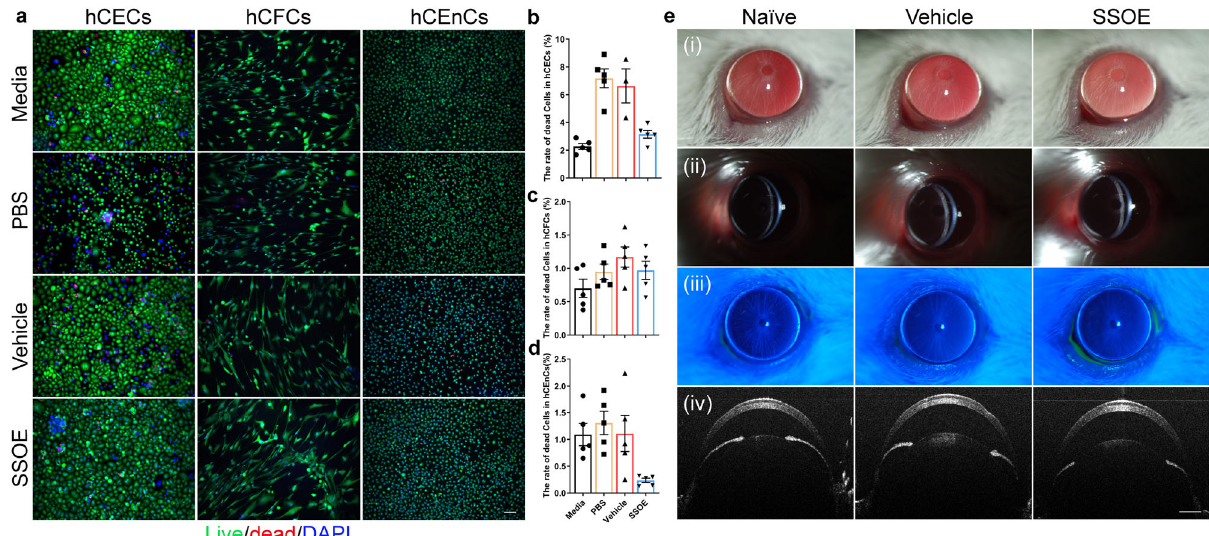
Fig.2|SafetyandbiocompatibilityofophthalmicSSOE.a Representativeimages of live/dead assay of human corneal epithelial cells (hCECs), human corneal fi bro- blastcells(hCFCs),andhumancornealendothelialcells(hCEnCs)after1hexposure toculturemedia,PBS,unoxygenatedvehiclecontrol,orSSOE(scalebarrepresents 100 μ m).PercentagesofdeadcellsinhCECs( b ),hCFCs( c ),andhCEnCs( d )inSSOE groupwerecomparableorlowerthanthoseinculturemediaandcontrols.Dataare presented as mean±SEM. hCECs: n =5, 5, 3, 5 individual samples in media, PBS,